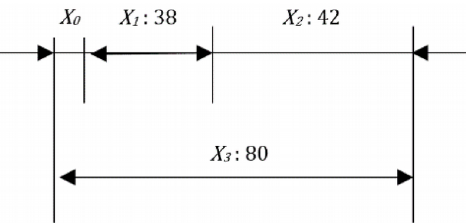
Figure 2. The dimensional chain